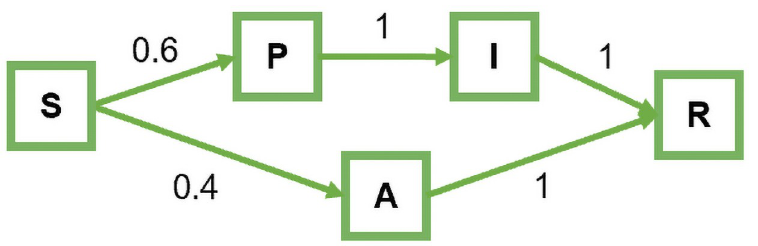
Fig 1. Agent state transition graph. Agents are always in one of five mutually exclusive states: susceptible ( S ), presymptomatic ( P ), infected with symptoms ( I ), asymptomatically infected ( A ), or recovered ( R